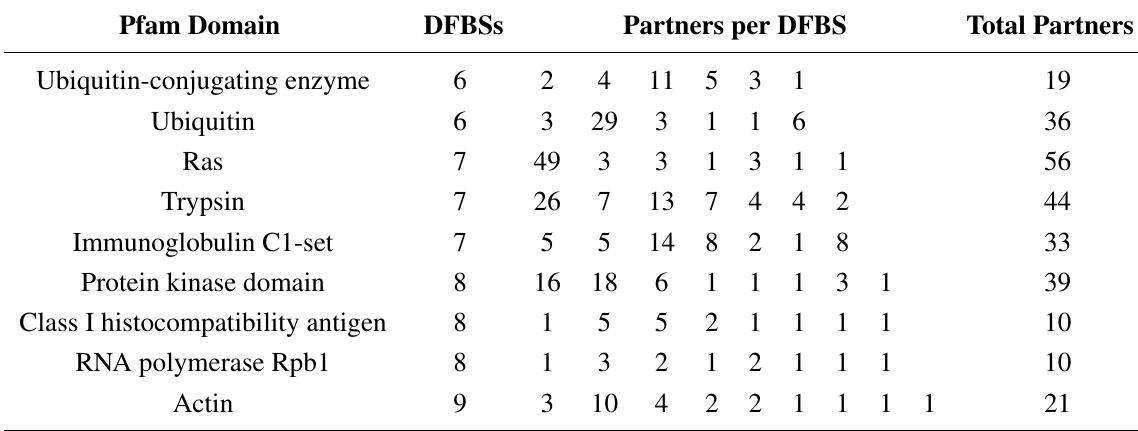
Table 7. The numbers of distinct Pfam domain partners for the nine Pfam domains having the greatest numbers of